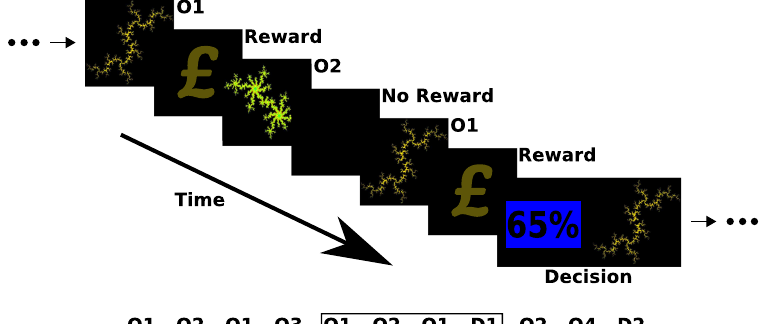
Figure 1. Experimental paradigm. Subject passively observed different fractal stimuli which were followed by reward (a pound symbol) or no reward (blank screen). Interleaved with these observations were decision prompts in which they had to make a choice between one of the observed fractals (for which they could estimate reward probability) and an explicit numeric probability value in order to maximize their reward. An example of a longer sequence is shown at the bottom with the encased subsequence depicted above.